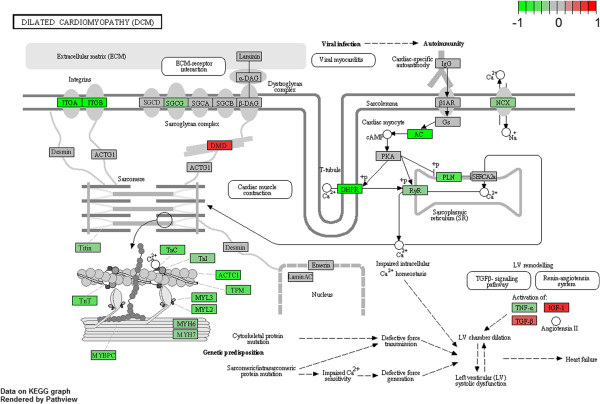
Dilated cardiomyopathy pathway from KEGG. Genes are colored according to their GSEA calculated scores.